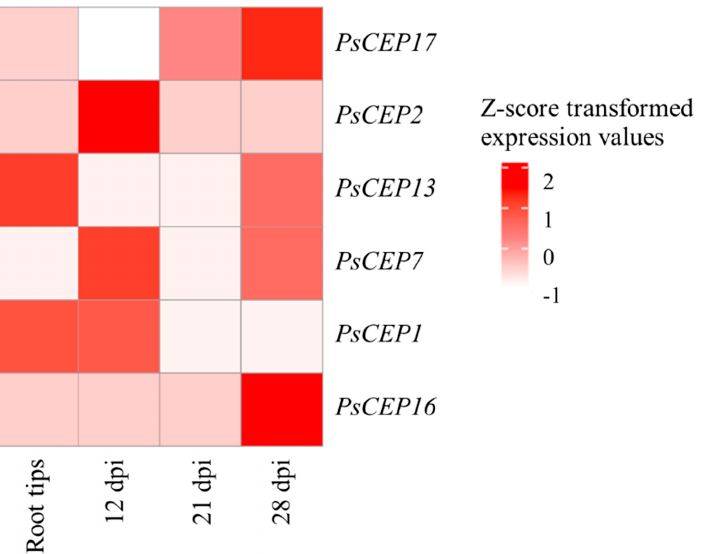
Figure 10. Heatmap illustrating the expression levels of the PsCEP genes in symbiotic nodules. Only those PsCEP genes which have transcript abundance ≥ 10 according to the data by Zorin et al. [29] are shown.